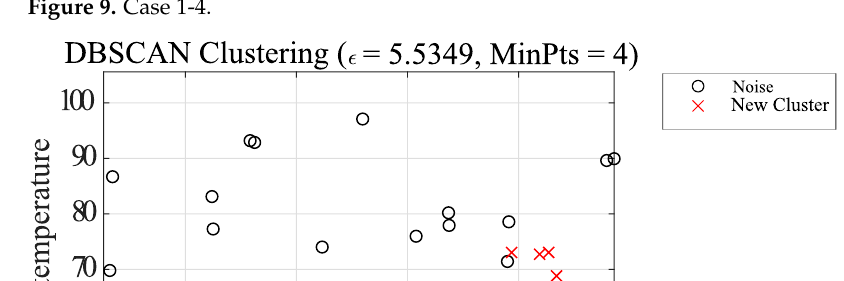
Figure 9. Case 1-4.